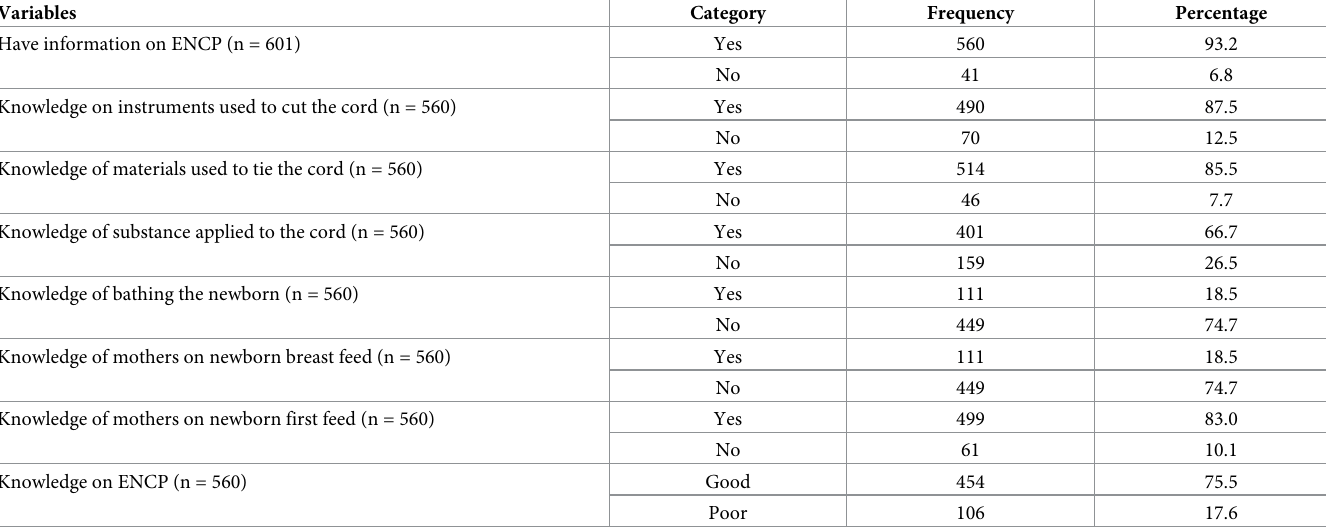
Table 3. Knowledge status of home delivered women toward essential newborn care, in Guto Gida district, Oromia regional state, Ethiopia, September 2020. Variables